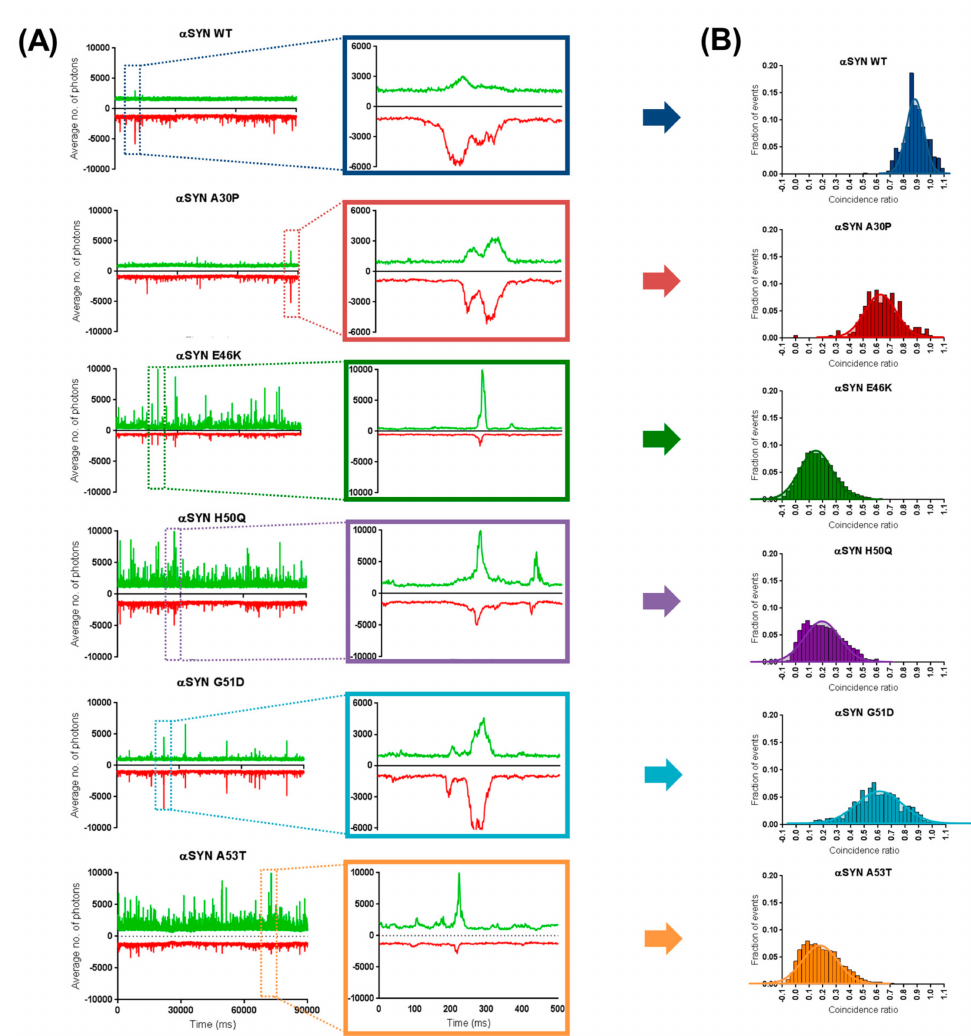
Figure 3. Two-color coincidence unveils the selective mechanism by which β -synuclein inhibits the aggregation of the different α -synuclein mutants. ( A ) For systematic coincidence measurements, only 1:1 ( β : α ), 90 s traces were selected and three measurements were performed for each protein using a scanning-well microscope approach. Examples of traces and the detailed fluorescent bursts used for coincidence plots show the different trend across the different pathological mutants. ( B ) Coincidence ratios between the traces of mCherry β -syn WT and sGFP α -syns were plotted for a total number of at least 400 events. For each trace, the threshold for an “event” was defined as any burst ≥ average expression + standard deviation of pure GFP